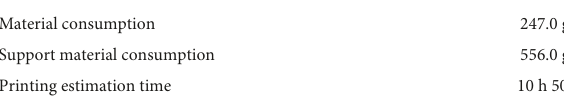
TABLE 1 Main features of 3D surgical guide